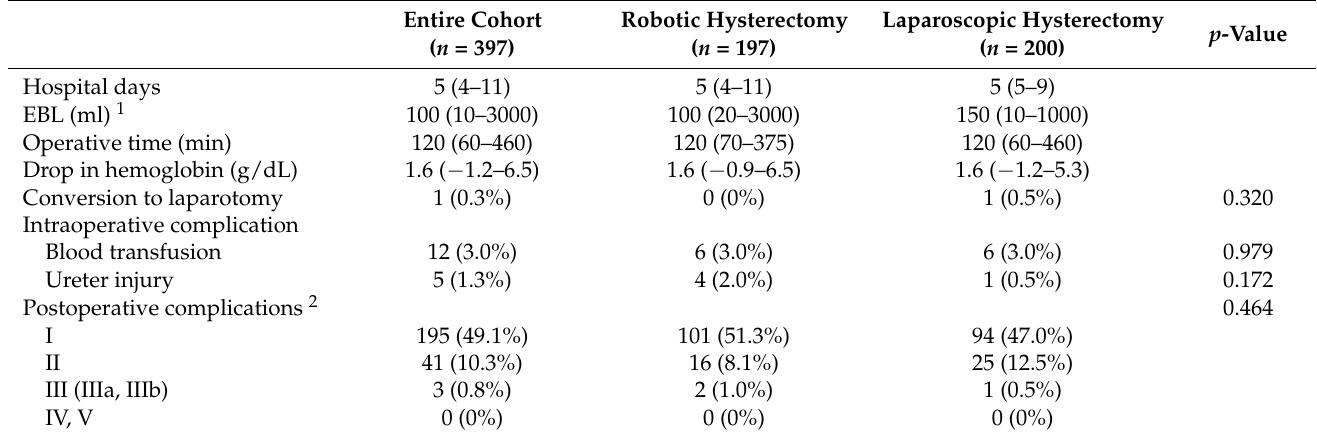
Table 2. Surgical outcomes by the surgery type of